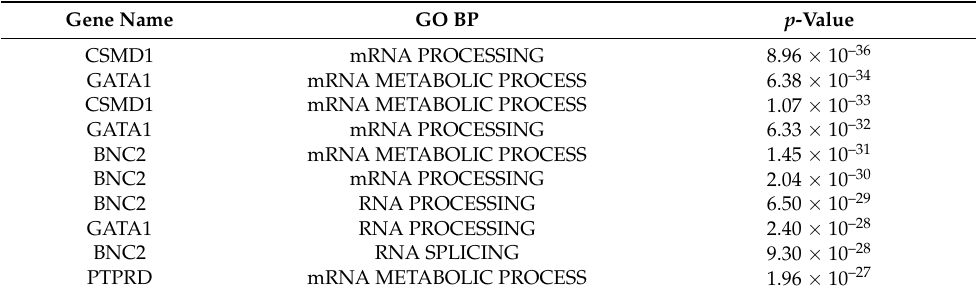
Table 2. Significant results of functional enrichment analysis. Please note that the same gene is significantly linked to related gene